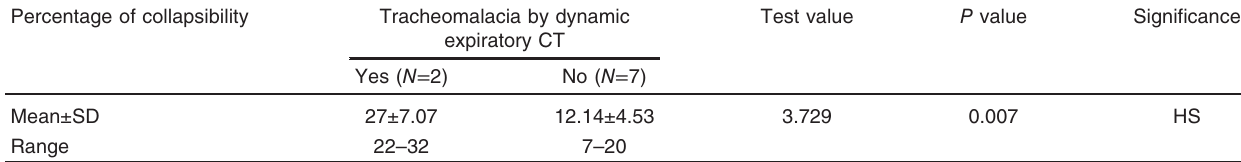
CT, computed tomography; HS, highly